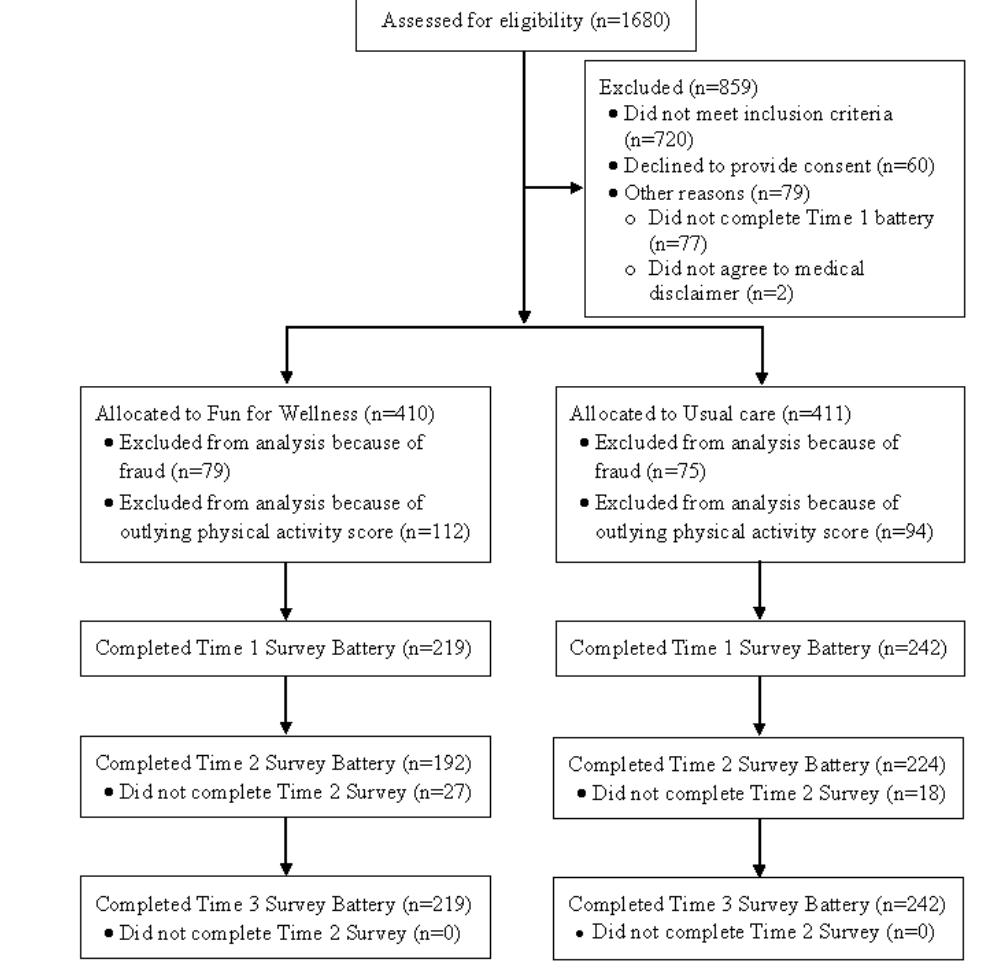
Figure 2. Participant flow from screening to randomization to retention over the three measurement occasions for the physical activity–related